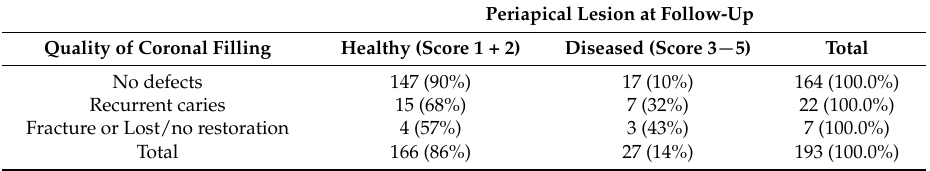
Table 6. Relationship between the quality of the coronal filling and the periapical lesion (PAI) at